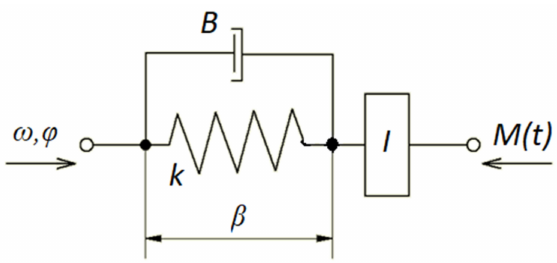
Figure 2. Electromechanical vibrating set of a synchronous